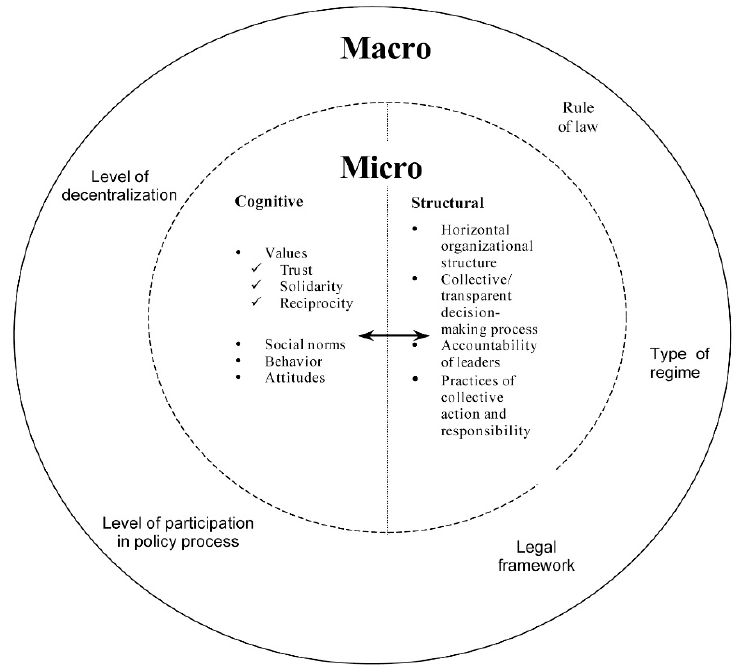
Figure 3: Social capital: Levels and types. A conceptual framework Source: Claridge, 2004, p. 41, adapted from Bain and Hicks,